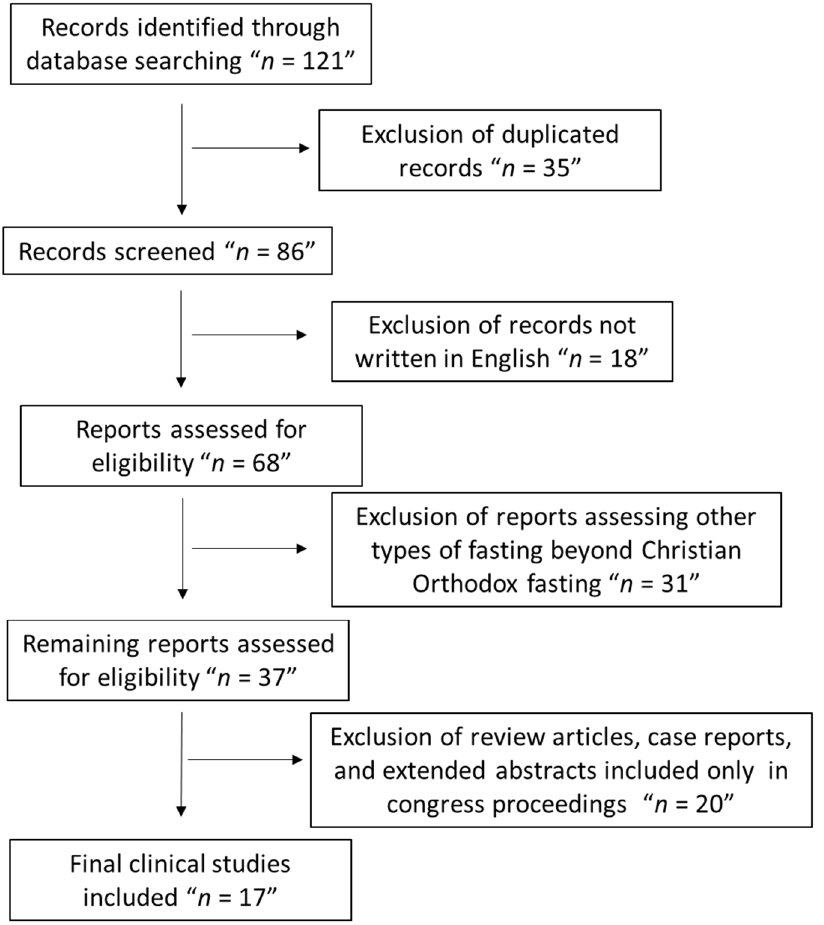
Figure 1. Flow chart of the study population.